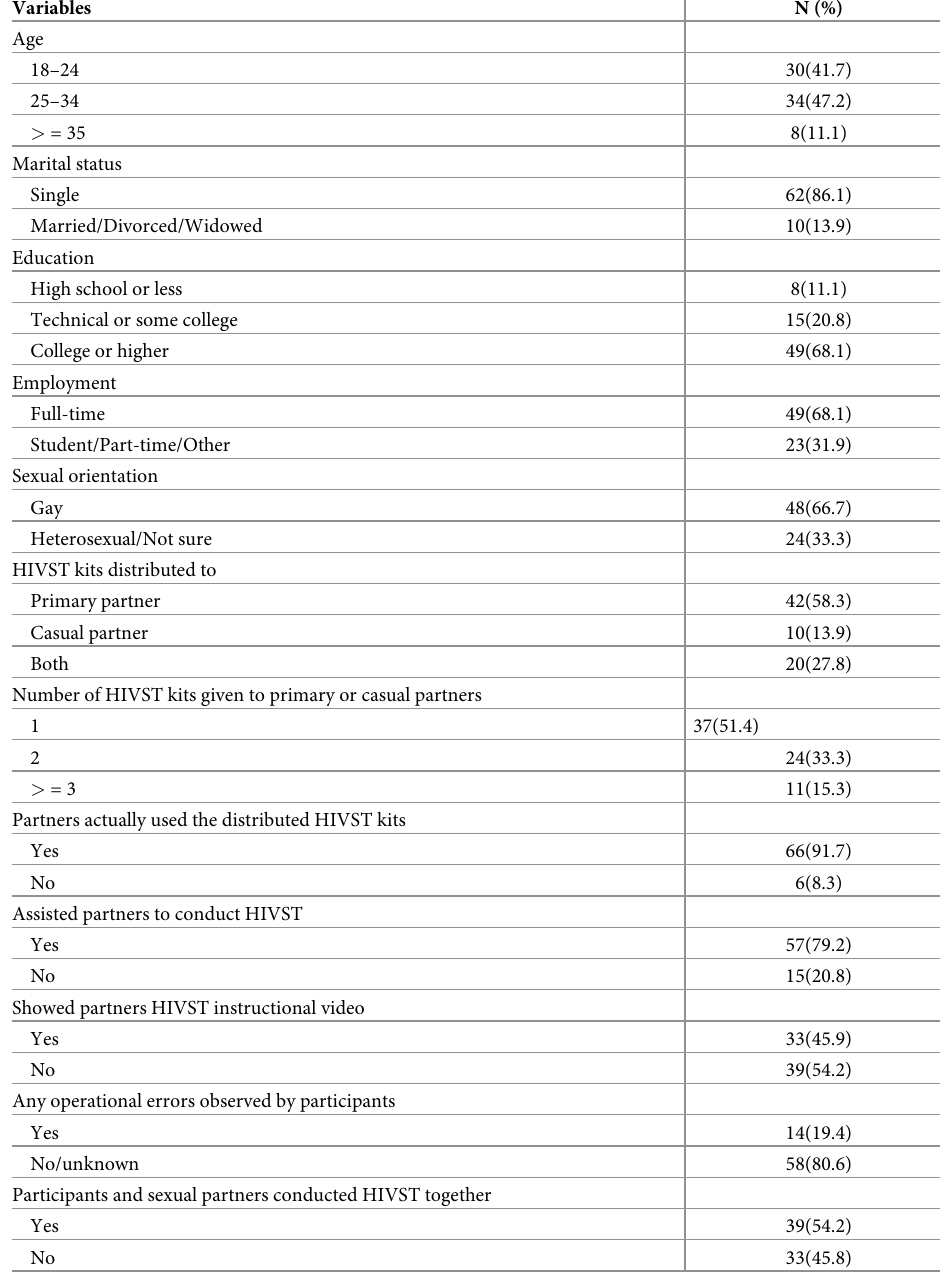
Table 1. Socio-demographic characteristics of distributors, and patterns and processes of HIV self-testing (HIVST) distribution among men who have sex with men in Nanjing, China, 2017 (N =